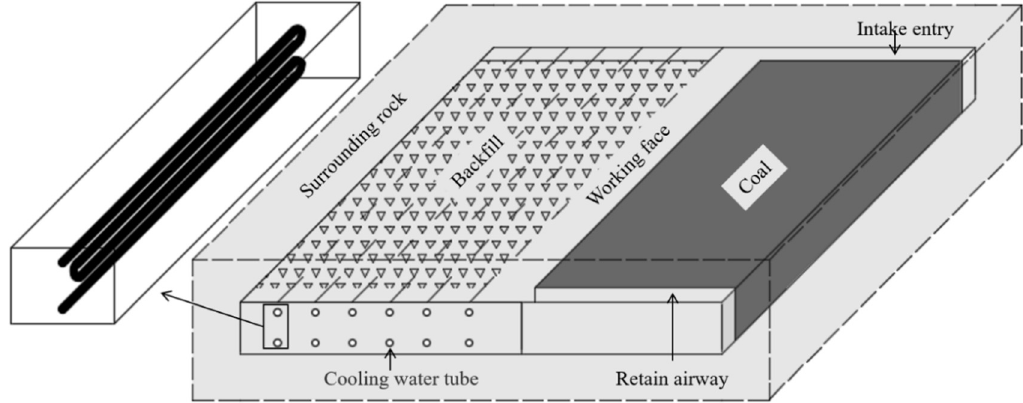
Figure 1. Schematic diagram of radiation cooling in the coal mining face.